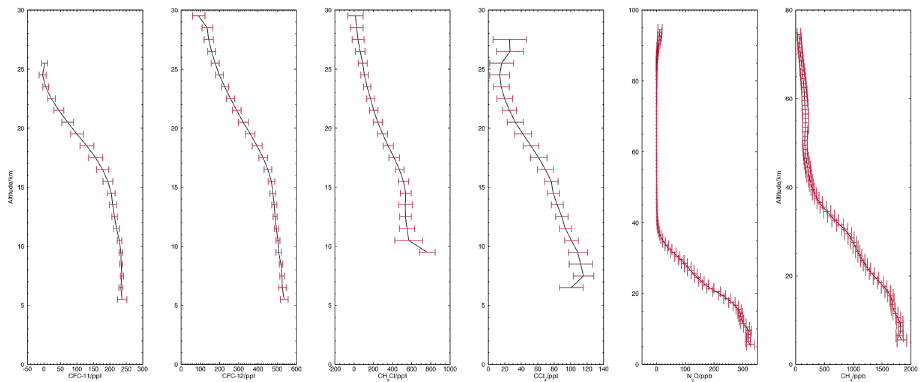
Figure C3 The mean vertical profile of CFC-11, CFC-12, CH3Cl, CH4 & N2O, calculated using data from 2009 between 60° and 45° North Fig. C4. The mean vertical profile of CFC-11, CFC-12, CH 3 Cl, CCl 4 , N 2 O and CH 4 , calculated using data from 2009 between 60 ◦ and 45 ◦